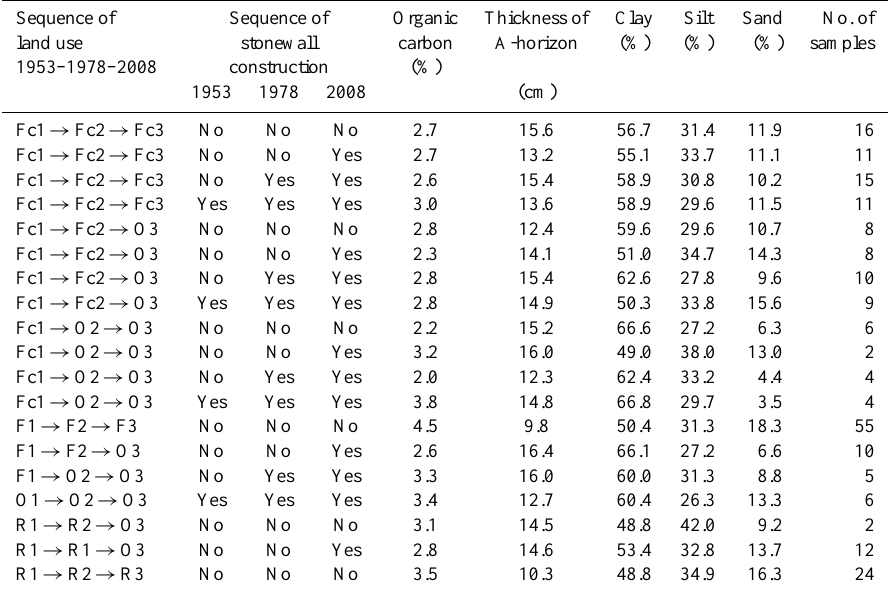
Table 7. Distribution of soil properties according to land use change by time of stone walls